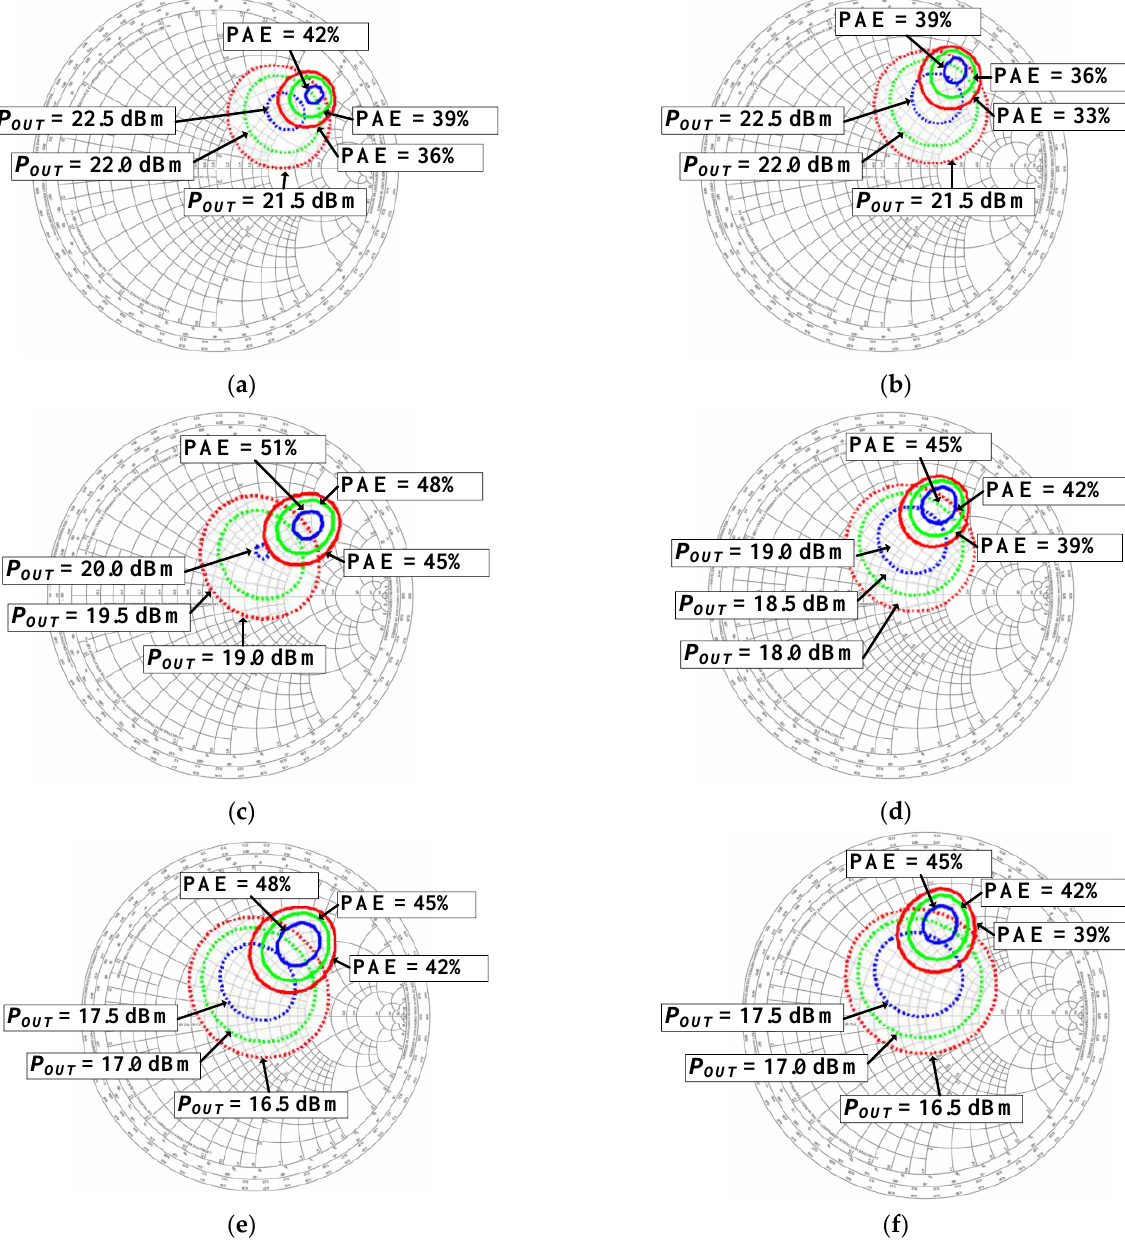
Figure 2. Load-pull simulations of the 4 × 37.5 µm GaN device at ( a ) 24 GHz and ( b ) 37 GHz for V DD = 12 V; ( c ) 24 GHz; and ( d ) 37 GHz for V DD = 6 V; ( e ) 24 GHz and ( f ) 37 GHz for V DD = 4 V all at around OP 1dB .